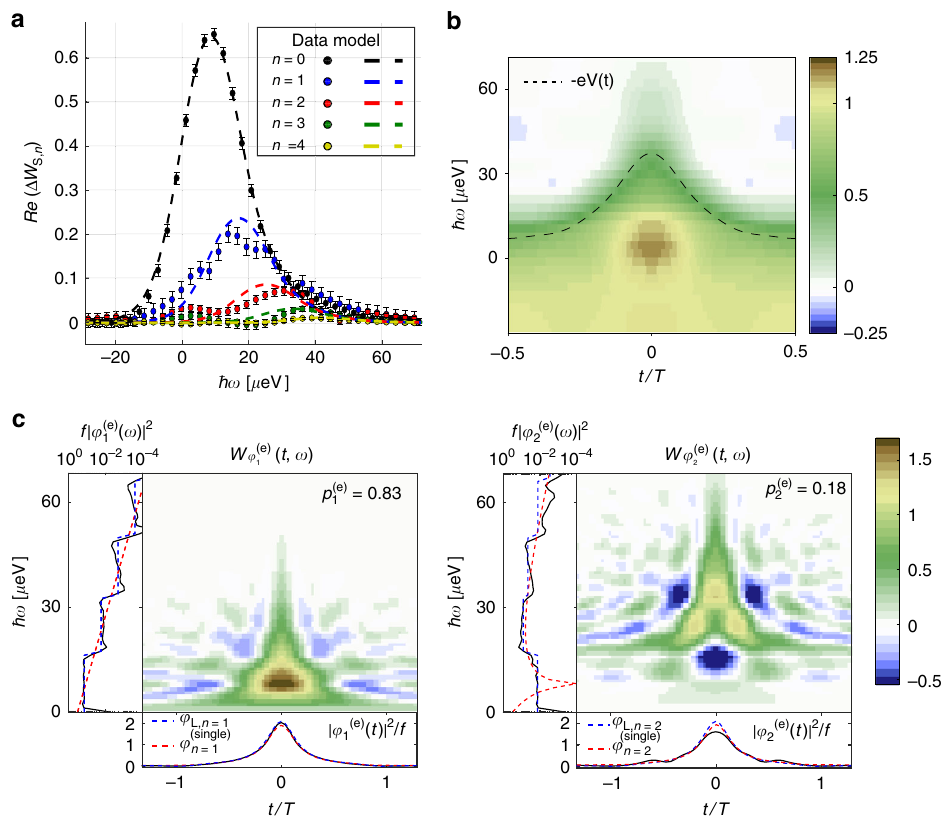
Fig. 5 Electron wavefunction generated by a Lorentzian pulse, q = − e. a Measured Δ W S, n ( ω ) ( n = 0 to n = 4) for the single-electron Lorentzian pulse at f = 4 GHz, τ = 42 ps, and T el = 50 mK. Error bars are de fi ned as standard error of the mean. b W S ( t , ω ), the dashed line represents the voltage pulse V ( t ) = h /e 2 I ( t ), where I ( t ) is obtained by integrating W S ( t , ω ) on energy ω . c Wigner representation of φ ð e Þ ð t Þj 2 and energy j φ ð e Þ ð ω Þj 2 distributions obtained by integrating W the margins represent the time j φ ð e Þ i i log scale for better comparison with theoretical predictions with single shot φ ð single Þ n (red dashed line) and periodic φ L, n (blue dashed line) Lorentzian wavepackets (with τ = 42 ps). As it can be seen from the very good agreement with the blue dashed line, the steplike behavior of j φ ð e Þ periodicity of the